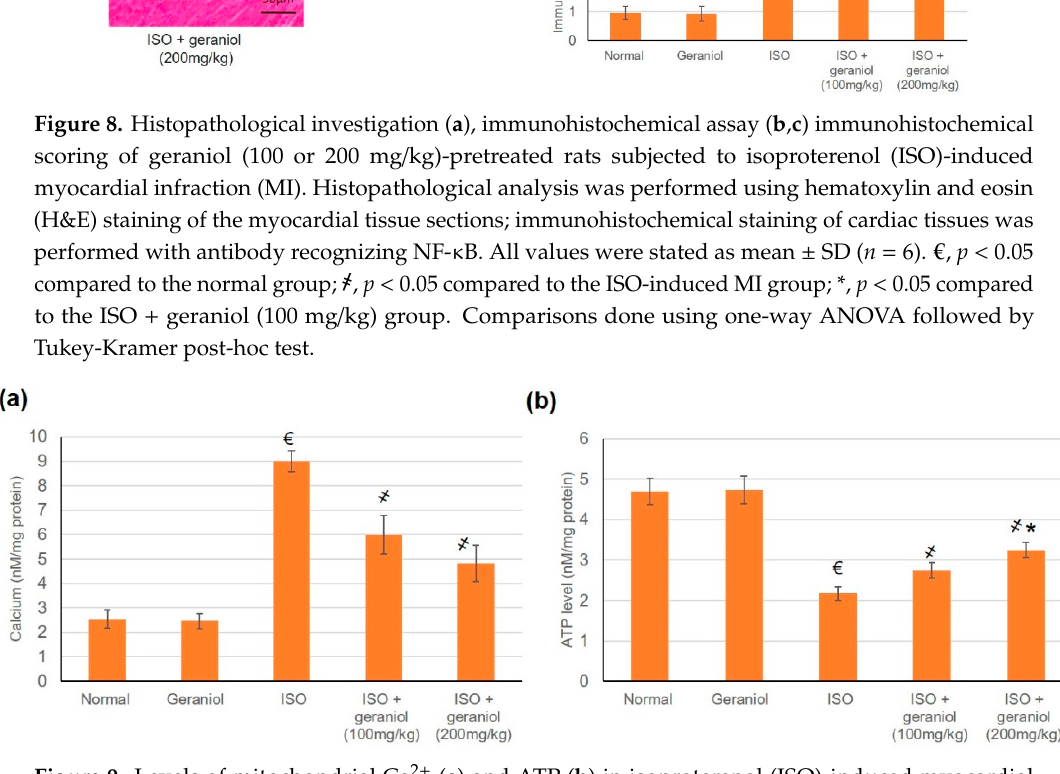
Table 2. The impact of geraniol pretreatment on ECG components in isoproterenol-induced myocardial infarction. ECG